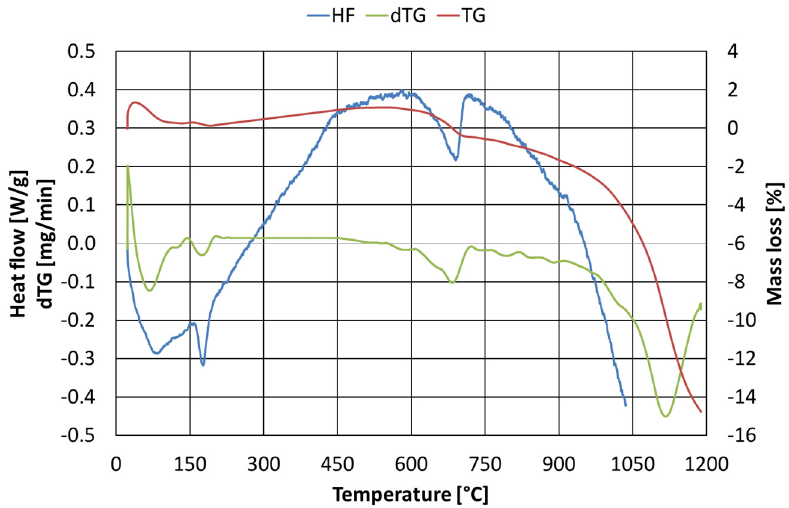
Figure 13. Thermal gravimetric–differential scanning calorimetry (TG-DSC) results of combustion chamber residue thermal analysis. Table 11. Transformation temperature from TG-DSC of combustion chamber thermal analysis.